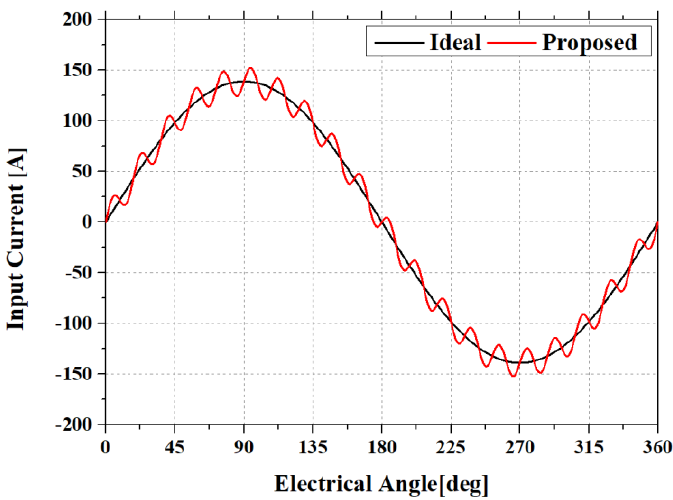
Figure 2. Comparison of the ideal current and the harmonics injected current